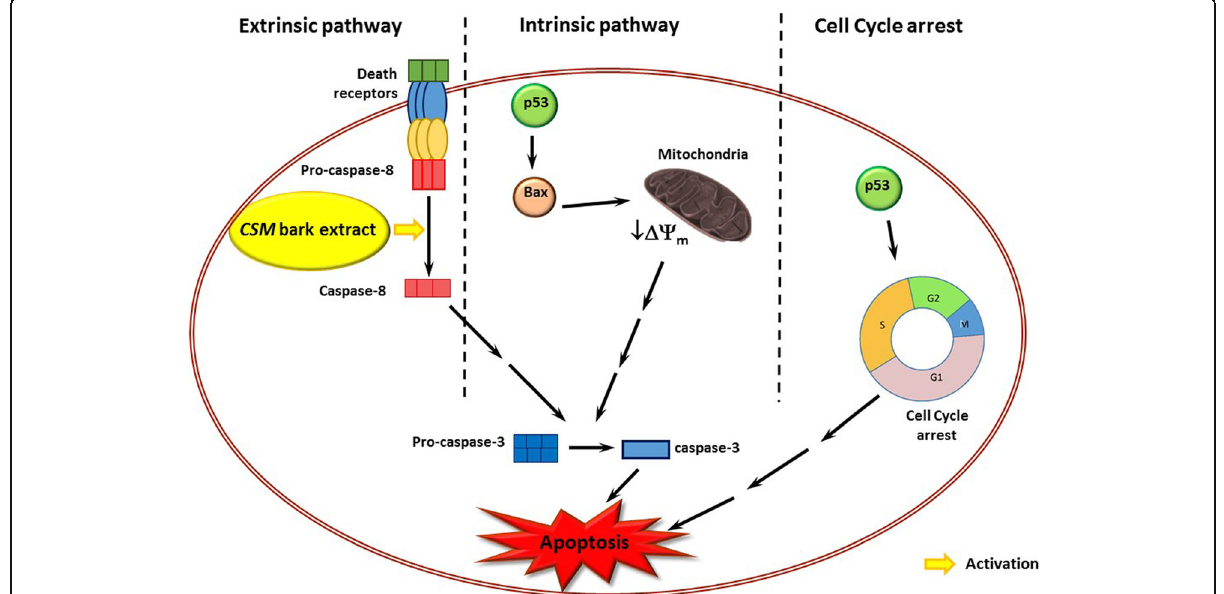
Fig. 7 Schematic mechanism of anticancer activity of CSM bark